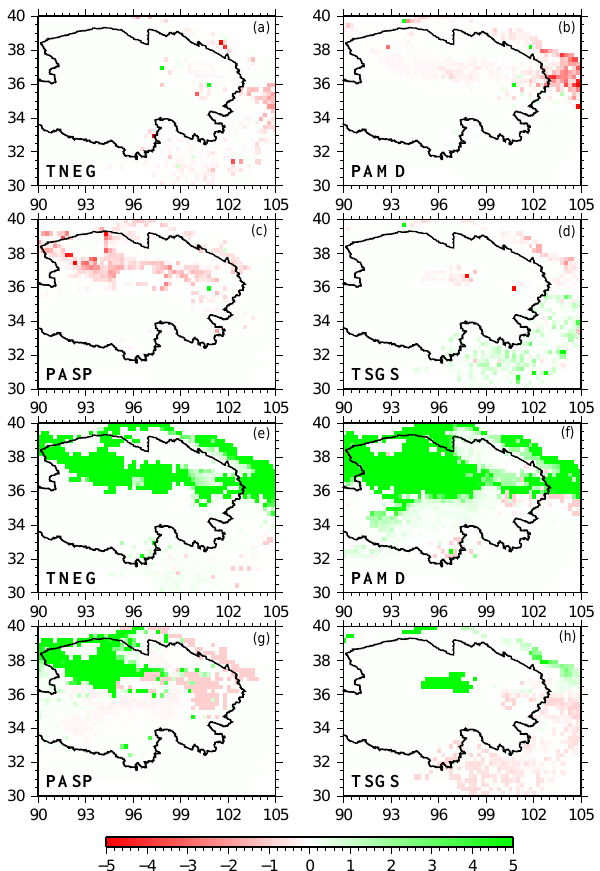
Figure 10. Elasticity of individual FPCs with + 1 ◦ C soil tempera- ture increase (a–d) and 10% soil moisture increase (e–h)